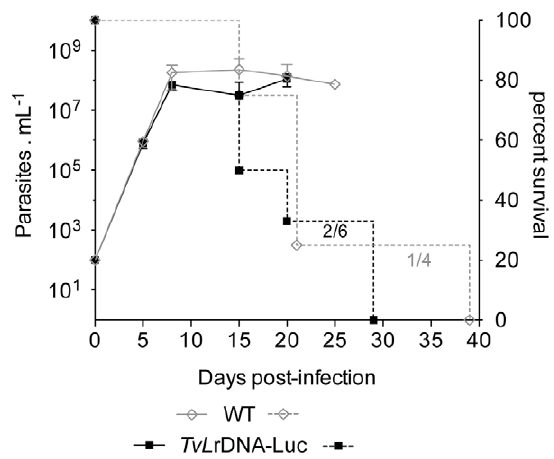
Figure 7. Mutant Tv LrDNA-Luc strain displays the same levels of invivo infectivity and virulence as WT T.vivax . Four to six Outbred mice were injected intraperitoneally with 10 2 WT ( e ) or Tv LrDNA-Luc ( & ) BSF T. vivax parasites and parasitemia were followed individually every 5 days. Continous and dotted lines stand respectively for parasitemias and cumulative survival rates, as determined by Kaplan-Meier methodology. Parasitemias are expressed as arithmetic means 6 SD. No significance was observed between the curves, as ascertained by the Mantel-Cox log-rank test where p . 0.5.